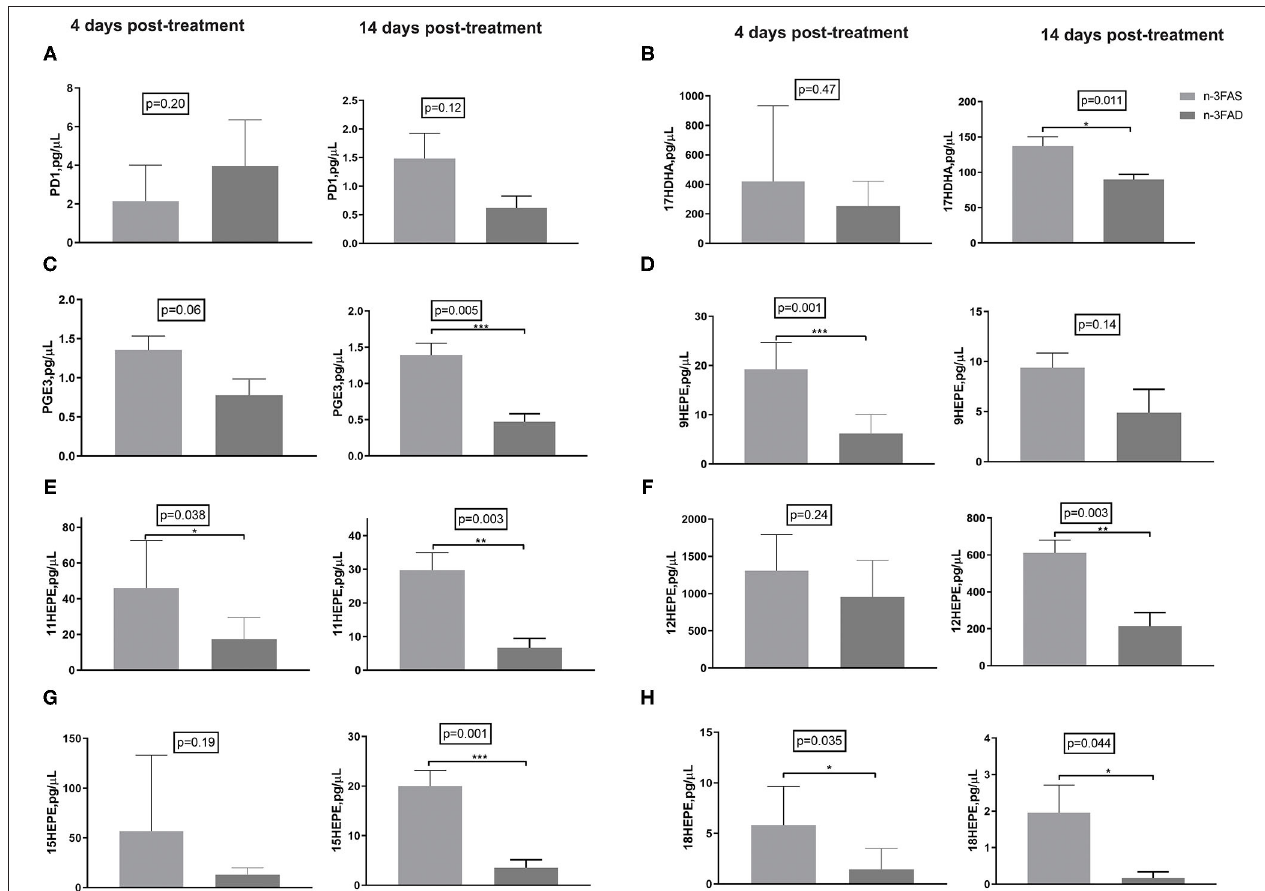
FIGURE 5 | Effects of conditioning on lipid mediators in crude lung homogenate at the local site of intervention (A) PD1, (B) 17-HDHA, (C) PGE3, (D) 9-HEPE, (E) 11-HEPE, (F) 12-HEPE, (G) 15-HEPE, and (H) 18-HEPE. The data are represented as mean ± SEM of n = 6 mice/group and representative of two independent experiments. Unpaired two-tailed t -tests were used to compare means, significance at * p < 0.05, ** p < 0.01, *** p < 0.001. PGE3, Prostaglandin E3; PD1, Protectin D1; HDHA, hydroxydocosahexaenoic acid; HEPE, hydroxyeicosapentaenoic acid; n-3FAS, omega-3 fatty acid-sufficient diet group; n-3FAD, omega-3 fatty acid-deficient diet